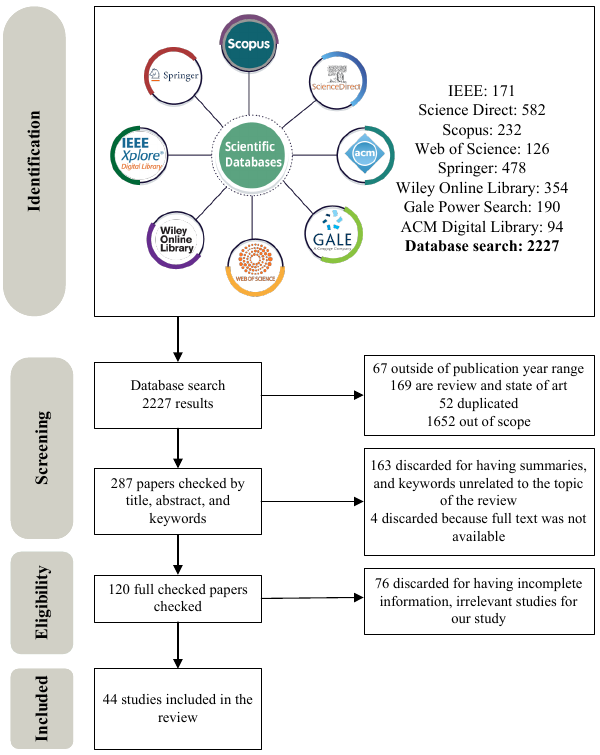
Figure 1. Stages of the PRISMA